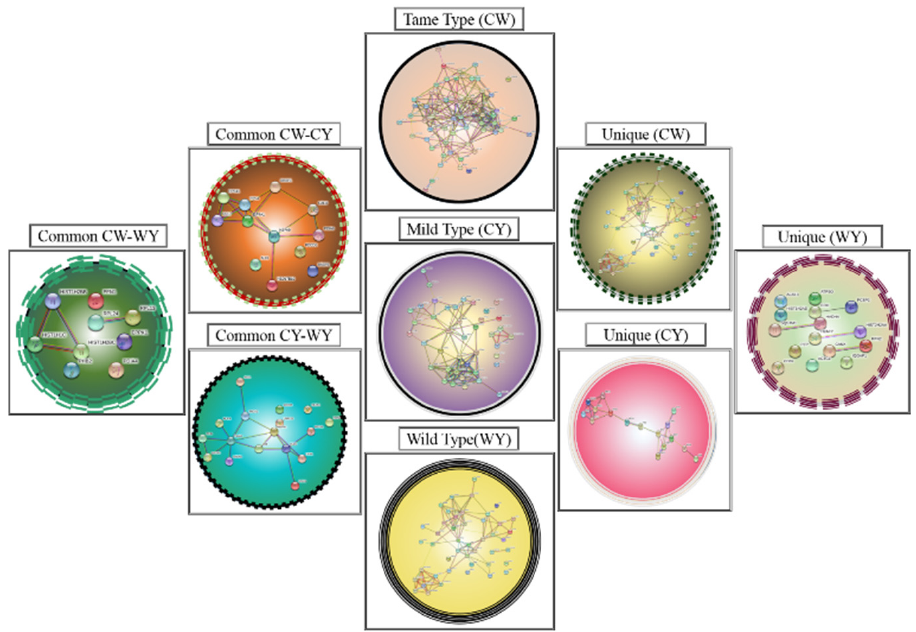
Figure 8. A STRING analysis showing the protein–protein interaction of differentially expressed